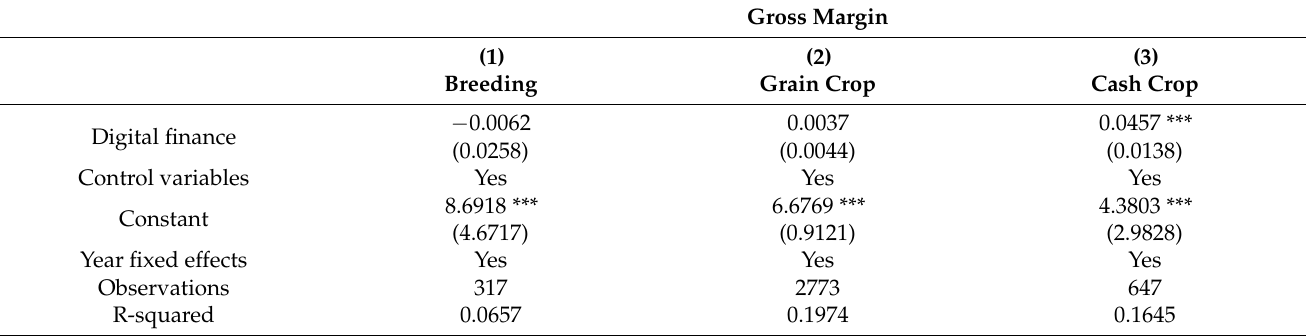
Table 9. Estimated results of different categories according to the types of agricultural